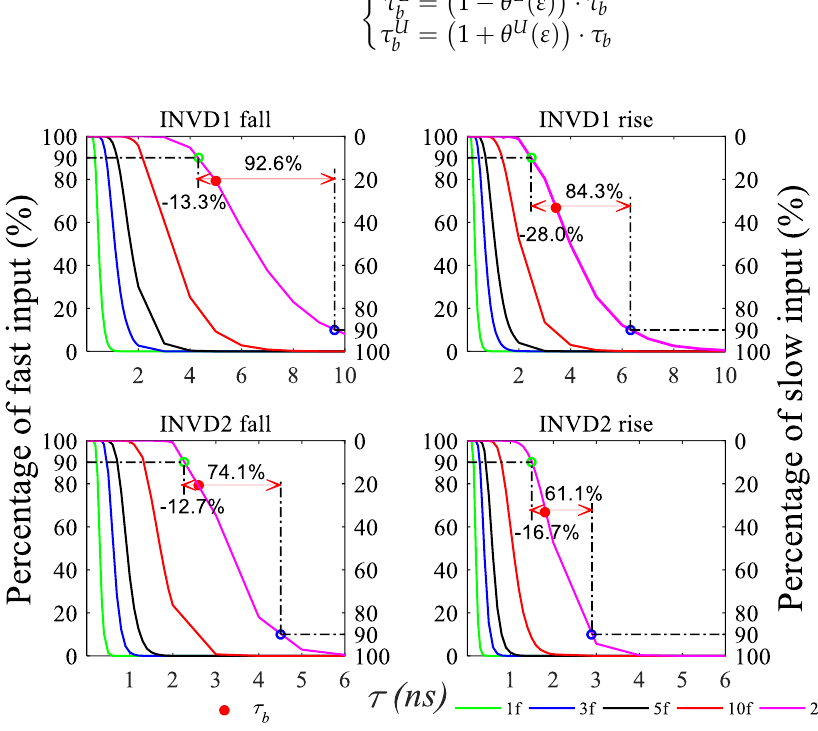
Figure 2. Transition procedure of fast/slow input slew due to process variation.